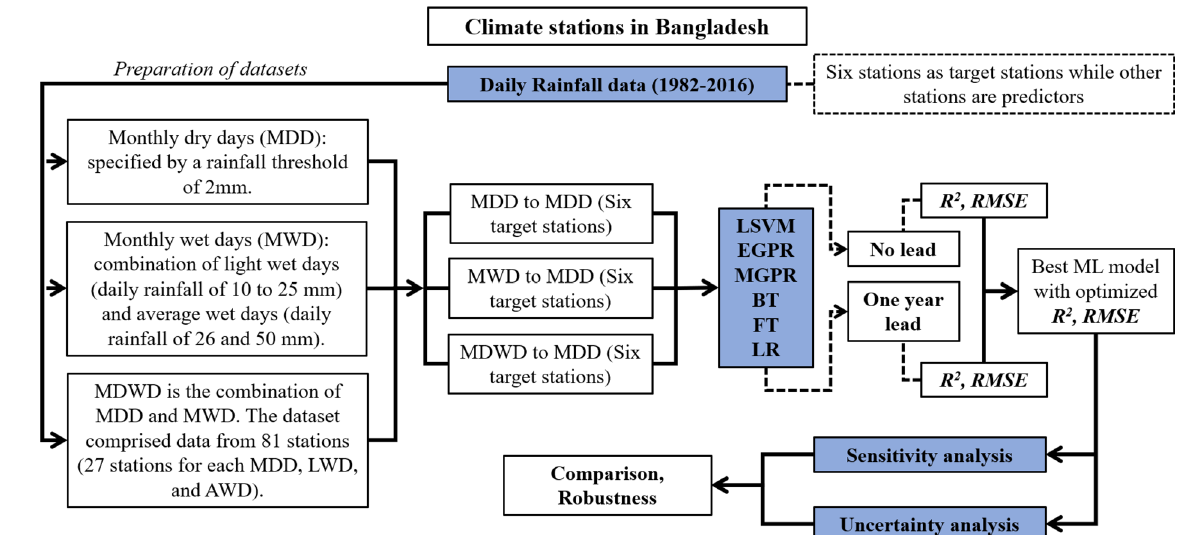
Figure 9. Procedural flow chart of the materials and methods in this